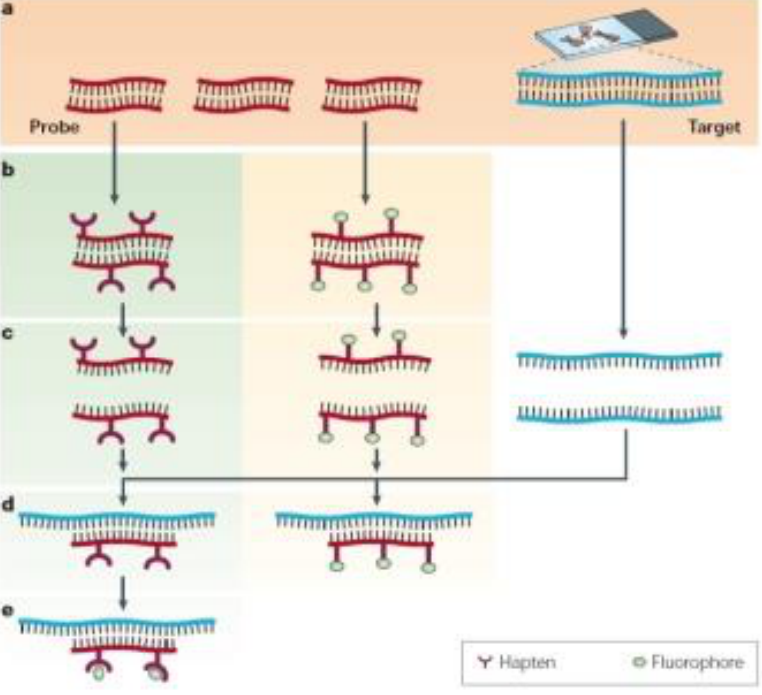
Figure 7. ( a ) The basic elements of FISH are a DNA probe and a target sequence. ( b ) Before hybridization, the DNA probe is labeled by various means, such as nick translation, random primed labeling, and PCR. Two labeling strategies are commonly used: indirect labeling (left panel) and direct labeling (right panel). For indirect labeling, probes are labeled with modified nucleotides that contain a hapten, whereas direct labeling uses nucleotides that have been directly modified to contain a fluorophore. ( c ) The labeled probe and the target DNA are denatured. ( d ) Combining the denatured probe and target allows the annealing of complementary DNA sequences. ( e ) If the probe has been labeled indirectly, an extra step is required for visualization of the nonfluorescent hapten that uses an enzymatic or immunological detection system. Whereas FISH is faster with directly labeled probes, indirect labeling offers the advantage of signal amplification by using several layers of antibodies, and it might therefore produce a signal that is brighter compared with background levels. Reprinted with permission from ref. [54]. Copyright 2008, Nature Education